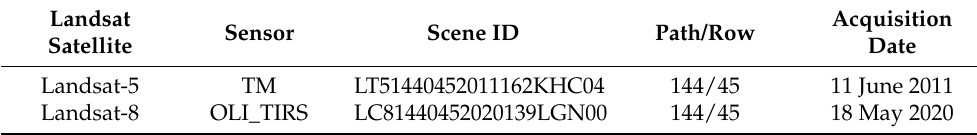
Table 1. Details of Landsat-8 satellite imaginary used in the study.